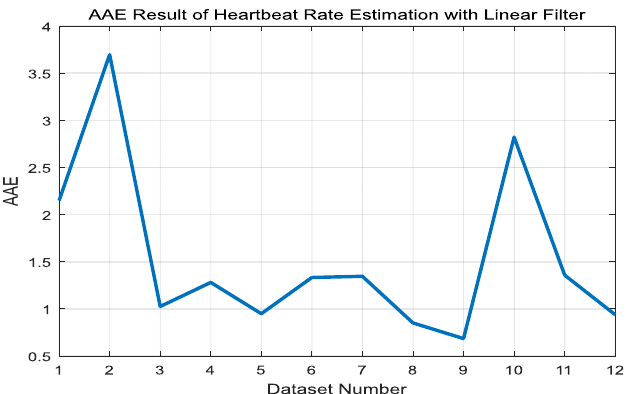
Figure 7. AAE’s of the linear filter of dataset 10 for each dataset.